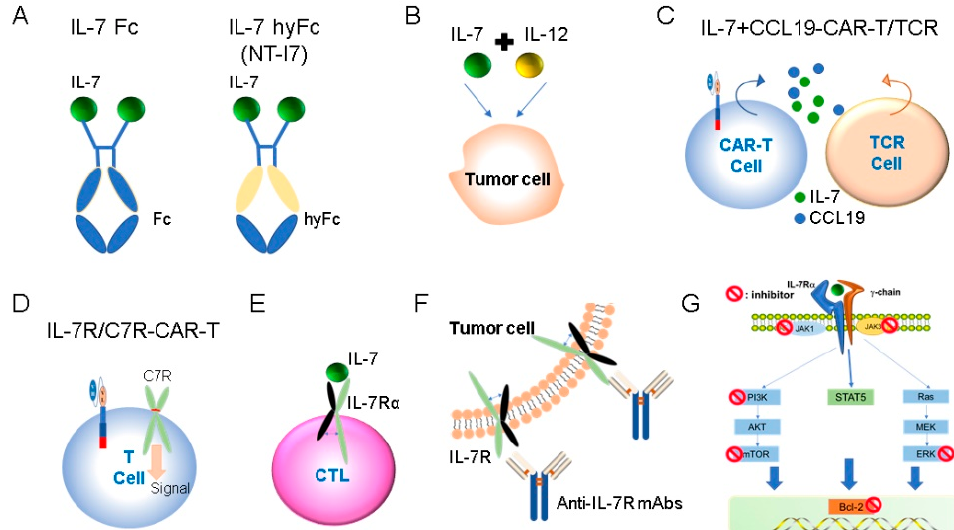
Figure 3. Application of IL-7 and IL-7R in cancer immunotherapy. ( A ) Recombinant IL-7 administration. ( B ) Combination use of IL-7. ( C ) CAR-T and TCR T cell expressed IL-7. ( D ) CAR-T expressing engineered IL-7R or C7R. ( E ) CTL expressed engineered IL-7R. ( F ) Anti-IL-7R monoclonal antibodies. ( G ) IL-7R pathway signaling inhibitors.